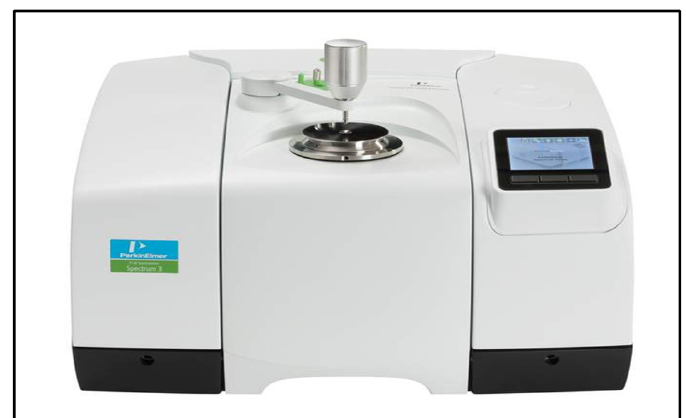
Figure 6. FTIR equipment.